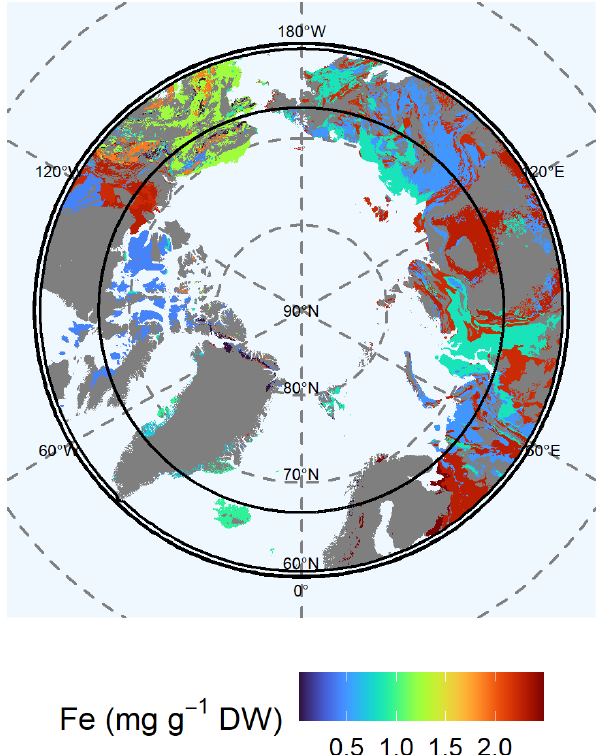
Figure 5. Map of the mean concentration of available (Mehlich- III-extractable) calcium (Ca) for the uppermost 100cm of soils. For each lithological class, the mean concentration is shown. Blue col- ors represent low concentrations of Ca, whereas red colors represent high concentrations. Gray shaded areas are not represented by our data.